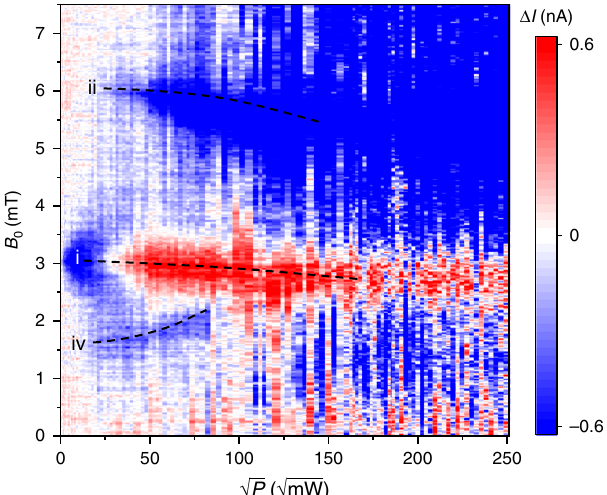
Fig. 3 Measured change in spin-dependent OLED current Δ I as a function of driving power. The dominant features of Fig. 2 are indicated by dashed ffiffiffi p P / B fi rmed for P ≤ 100 mW (see lines. The relationship 1 is con Supplementary Note 4), but, due to heating-induced resistivity changes of the microwire generating the resonant fi eld, the uncertainty on the abscissa scale increases with higher P